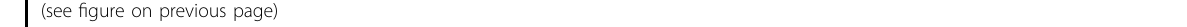
Fig. 2 GSK3 inhibition sensitizes CRC cells to PARPi. A Change in sensitivity to PARPi when combined with GSK3i. HCT-15 cells were treated with various PARPi, including simmiparib, talazoparib, rucaparib, olaparib, and niraparib, without or with speci fi c GSK3i CHIR99021 HCl (10 μ M) or LY2090314 (5 μ M) for 7 days. SP, simmiparib; TP, talazoparib; OP, olaparib; RP, rucaparib; NP, niraparib; CHIR, CHIR99021 HCl; and LY, LY2090314. Data (sensitive fold) are presented as the ratio of (IC 50 of PARPi)/ (IC 50 of PARPi plus GSK3i), indicating a reduction in IC 50 of PARPi in the presence of GSK3i. Color intensity represents the value of sensitive fold. B Dose-response curves for HCT-15 cells treated with the indicated concentration of simmiparib (SP) with or without the LY2090314 (LY: 1, 3, and 5 μ M) for 7 days. Data are from three independent experiments and expressed as mean ± SD. C and D G2/M arrest induced by single agent or the indicated combination in HCT-15 cells was determined using FACS. Cells were treated with 5 μ M simmiparib (SP), 5 μ M LY2090314 (LY), or a combination for 48 h and then subjected to FACS analysis. C Representative histograms are shown. D Percentage of cells in the G2/M phase expressed as mean ± SD from three independent experiments is shown. (*** p < 0.001, one-way ANOVA). E Apoptosis induced by single agent or the indicated combination in HCT-15 cells. Cells were treated with 5 μ M simmiparib (SP), 5 μ M LY2090314 (LY), or a combination for 72 h and then analyzed using annexin V-FITC-PI-staining-based fl ow cytometry. Percentage of apoptotic cells expressed as mean ± SD from three independent experiments is shown. (*** p < 0.001, one-way ANOVA). F Expression of apoptosis-related proteins in HCT-15 cells exposed to single agent or the indicated combination detected by western blotting. G GSK3 inhibitor, LY2090314 (LY), sensitized cells to PARP inhibitor, simmiparib (SP), in a panel of cells. The survival fraction and the average of CI values are shown from three independent